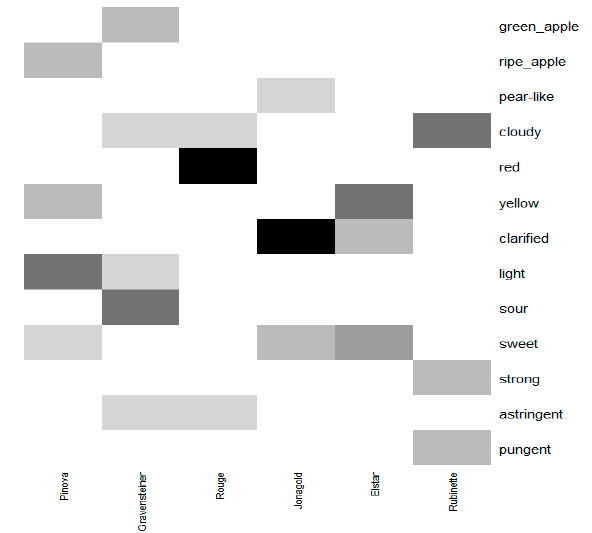
Figure 10. Heatmap of p -values < 0.05 obtained for each product and each descriptor from the binomial test. Darker colors indicate lower p -values ( < 0.000001), and lighter gray colors indicate higher p -values ( < 0.01).